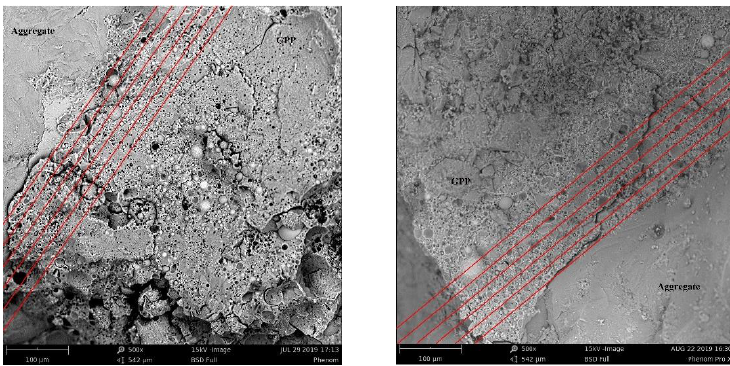
Figure 10. Samples of bands for SEM-EDS analysis. Table 4. Element concentrations (% ± STDV *) via SEM-EDS